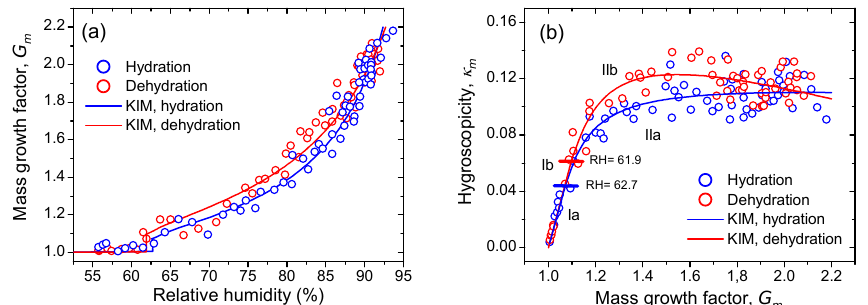
Figure 6. Hygroscopic properties of ambient atmospheric aerosols with preset m d = 3 . 5fg ( D b = 160nm): (a) mass growth factor ( G m ) observed as a function of relative humidity compared to KIM; (b) mass-based hygroscopicity parameter ( κ m ) calculated as a function of mass growth factor. The data points are from two repetitive experiments of hydration (blue circles) and dehydration (red circles). The lines are fits of KIM Eqs. (5) and (6). The labels I (Ia,Ib), II (IIa, IIb) indicate different regimes of hygroscopicity (Eqs. 5 and 6); the borders of the corresponding fit intervals are indicated by blue (hydration) and red (dehydration) bars (b)